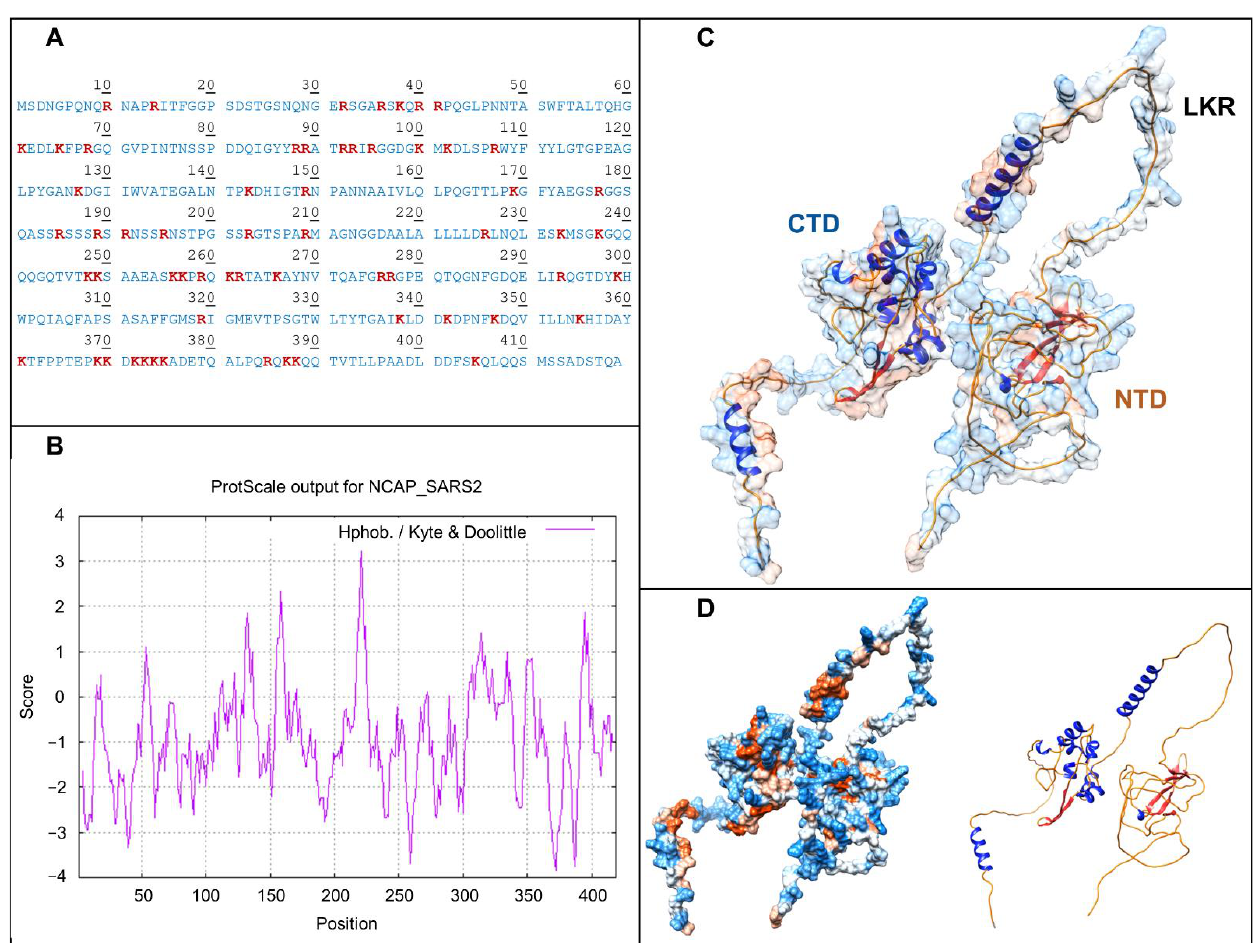
Figure 1. Physicochemical characteristics of SARS-CoV-2 nucleocapsid protein that make it a good candidate for MS processing and analysis. ( A ) Amino acid sequence, the 60 lysine and arginine are highlighted in bold red font; ( B ) Kyte and Doolittle hydrophobicity exhibiting the prevalence of polar regions along the N protein primary structure; ( C ) AlphaFold homology model where NTD, CTD, and LKR are indicated; ( D ) surface and ribbon models that show with detail the exposure of polar amino acid residues and the presence of a high proportion of unstructured regions.